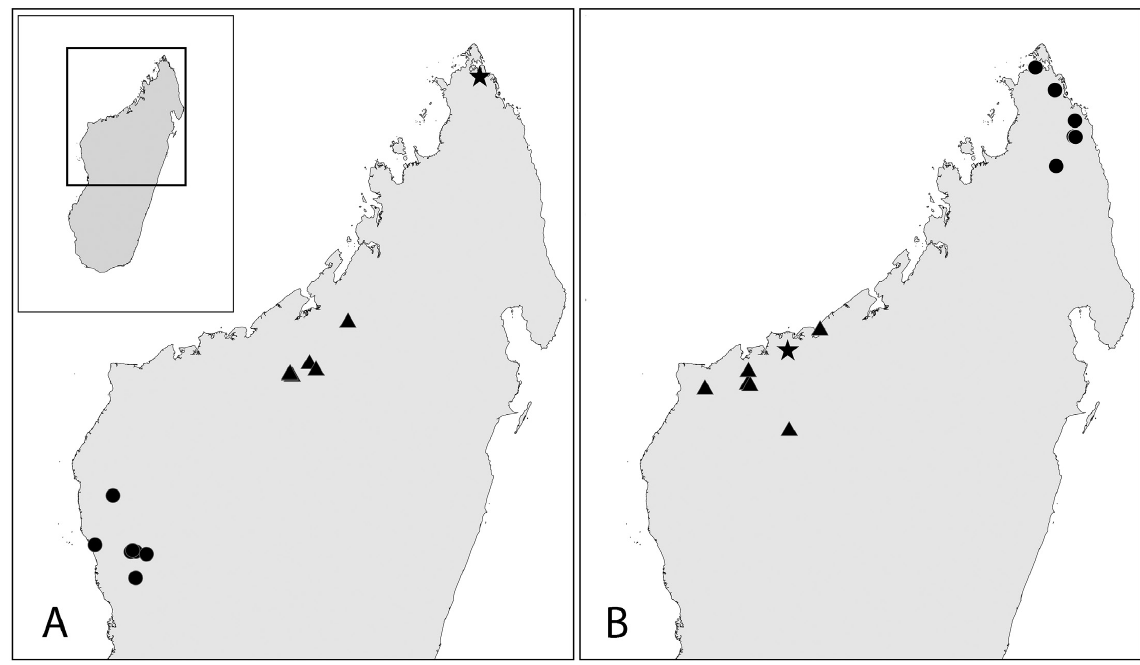
Fig. 6. Distribution maps of Homollea . A . H. furtiva De Block, sp. nov. ( ★ ), H. leandrii Arènes ( ● ) and H. longiflora Arènes ( ▲ ). B . H. perrieri Arènes ( ▲ ), H. septentrionalis De Block sp. nov. ( ● ) and unplaced material coll. ignot. 25309-SF ( ★